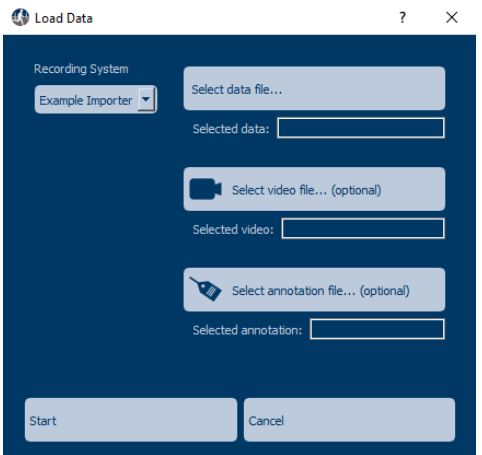
Figure 2. The load data dialog, where the user selects data to be